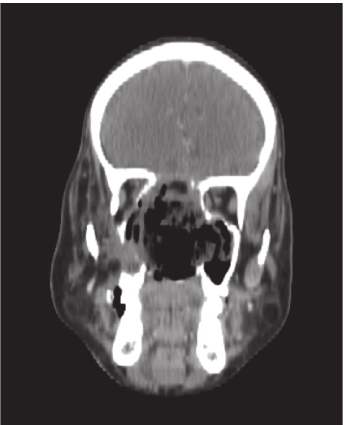
Figure 7: Coronal cut of contrast enhanced CT PNS showing postoperative changes and no recurrence.